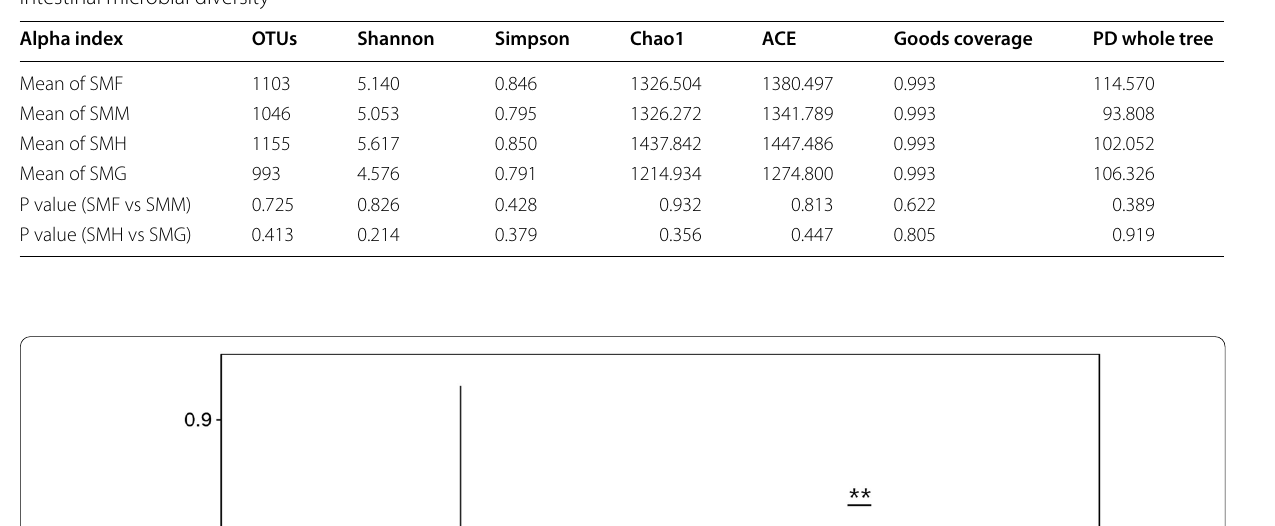
Fig. S9, Additional file 10: Fig. S10, Additional file 11: Fig. S11 and Additional file 12: Fig. S12).